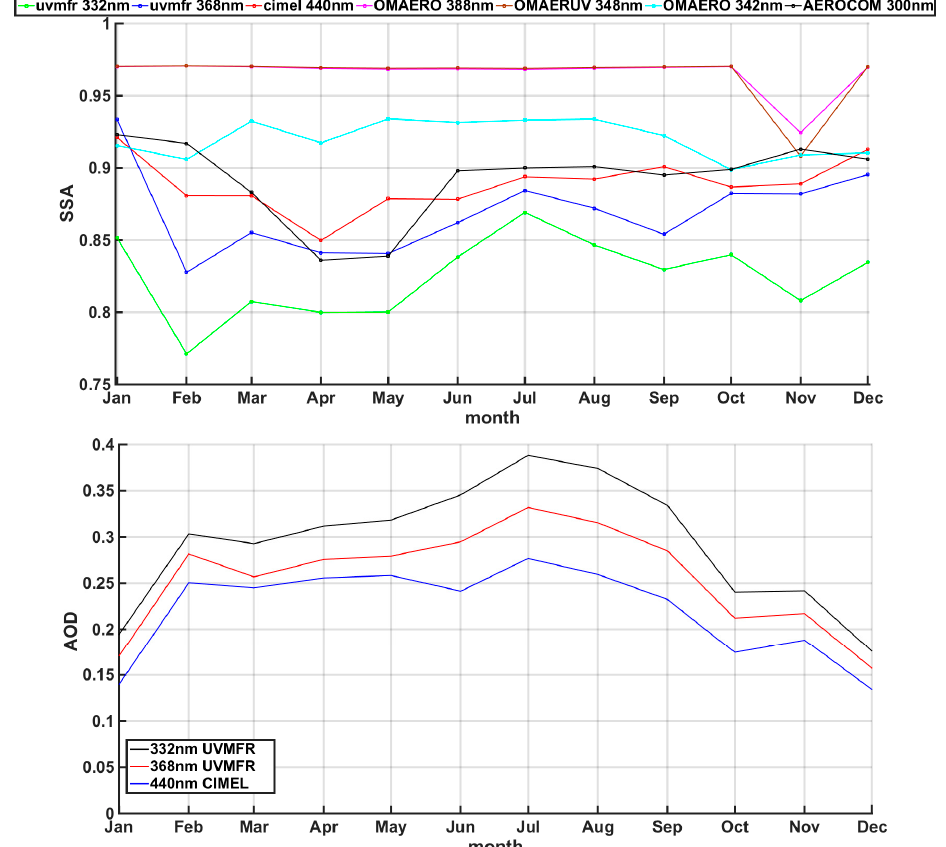
Figure 4. ( Top ): Mean monthly SSA values calculated by CIMEL and UVMFR time series and extracted from OMAERO, OMAERUV and AeroCom databases, for Athens during the 2009–2014 period. ( Bottom ): mean monthly values of AOD calculated using CIMEL and UVMFR time series.